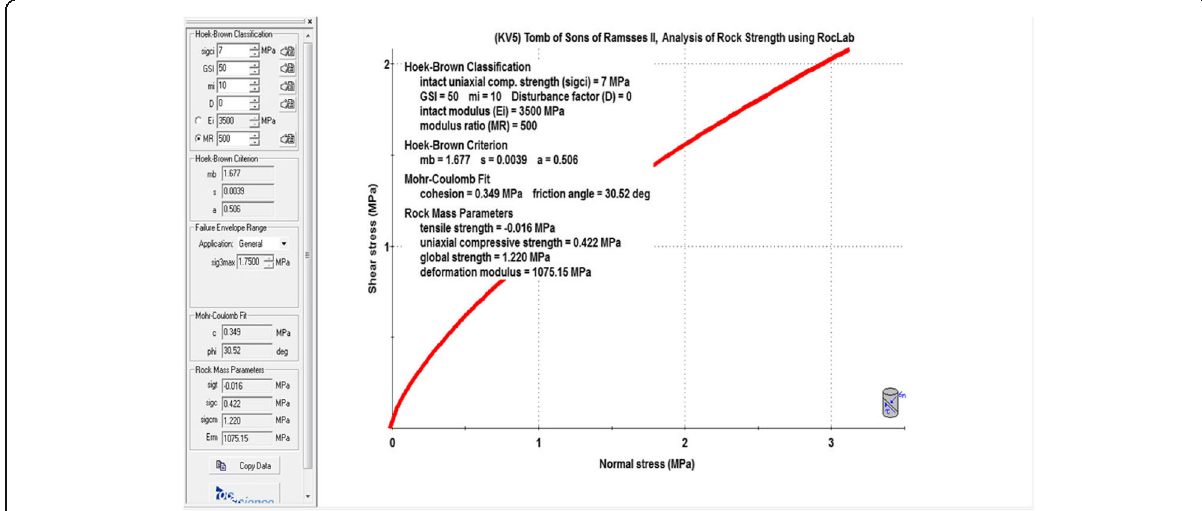
Fig. 12 Shear stress-Normal stress curve of Marl limestone (KV5), using the RocLab